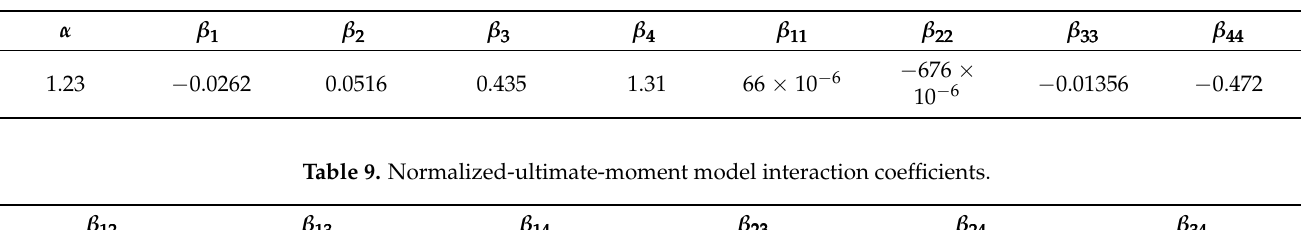
Table 8. Normalized-ultimate-moment model individual coefficients.